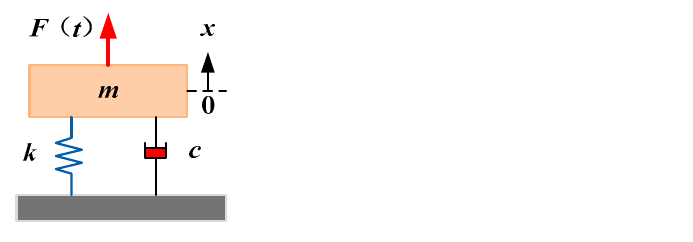
Figure 2. Typical schematic diagram of a passive vibration isolation system.